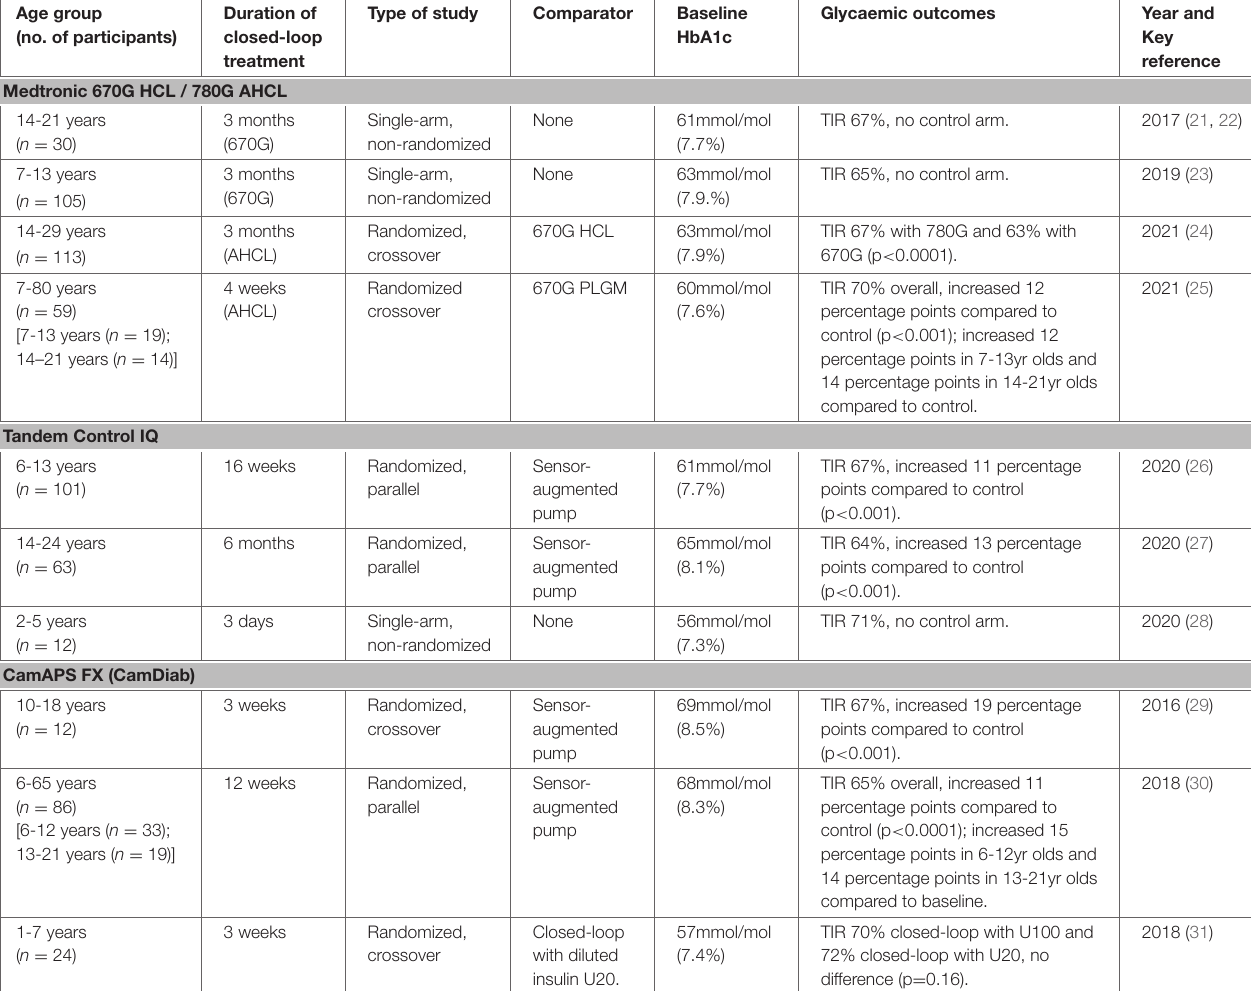
TABLE 1 | Key clinical trials of closed-loop insulin delivery in children and young people using commercialized systems. Age group (no. of